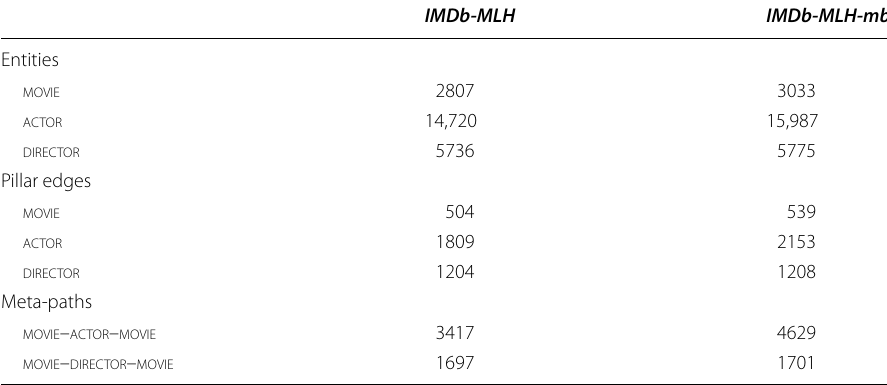
Table 2 Summary of across-layer network